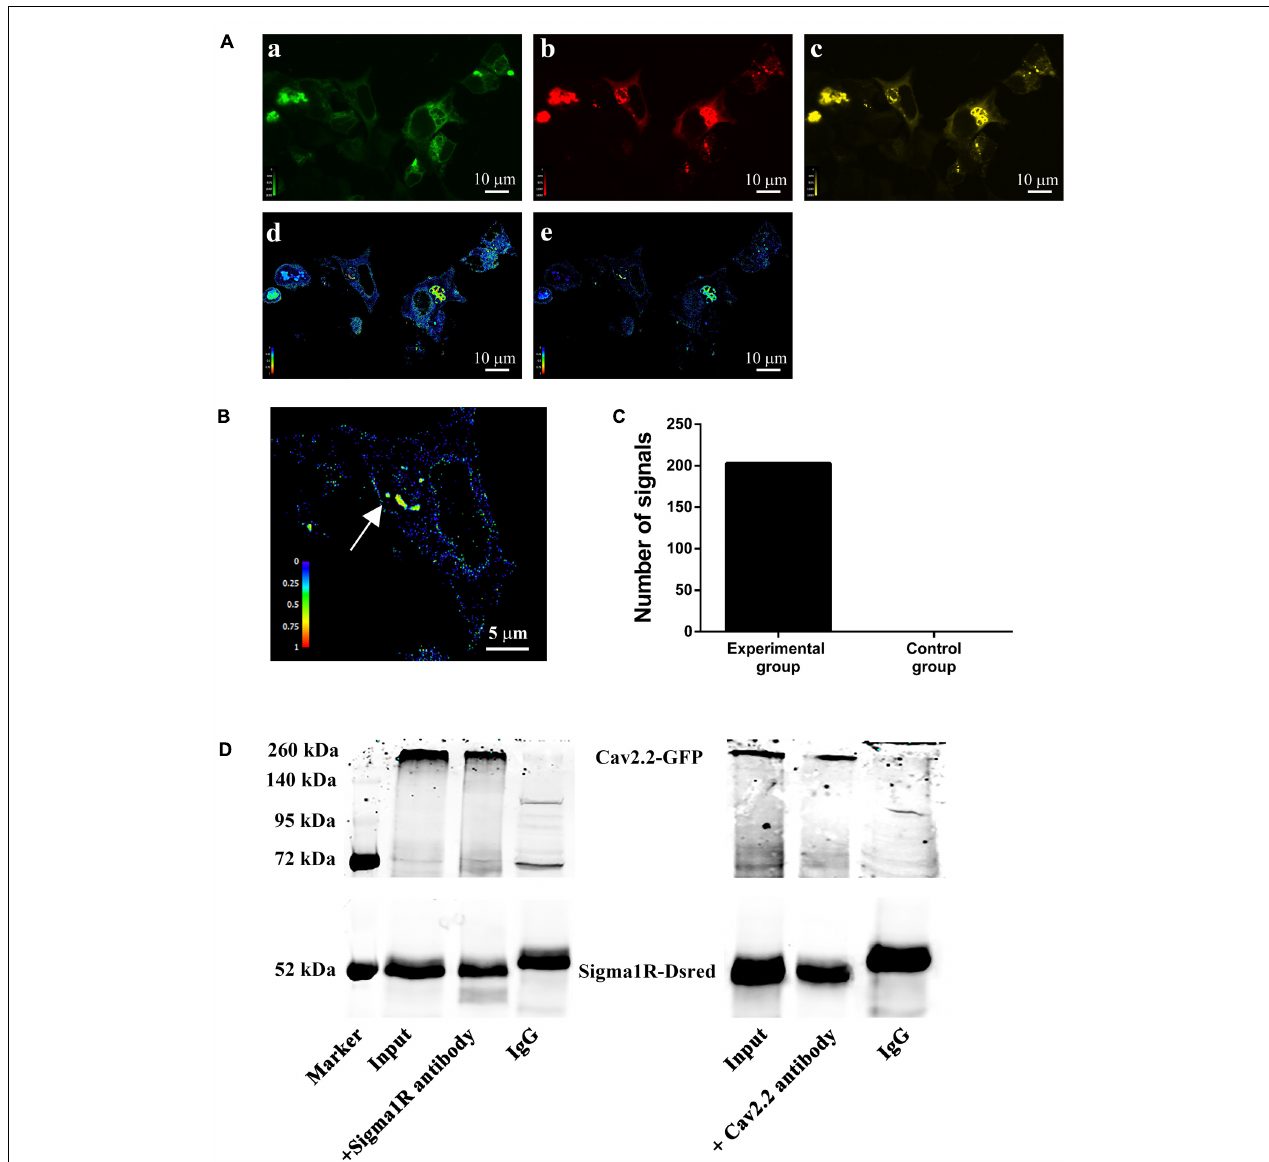
FIGURE 7 | Protein–protein interaction between sigma-1 receptors and N-type Ca 2 + channels. (A) HEK-293T cells were transfected with both Ca v 2.2-GFP ( α 1b+ β 1b+ α 2 δ 1) and sigma-1-Dsred receptor. Pseudo-color images were obtained under the three filter sets: GFP (a), Dsred (b), and FRET (c). After subtraction of background and bleed-through signals, net FRET (d) was acquired. Normalized FRET (e) values were got by using equation described in section “Materials and Methods.” Color bars represented relative degree of net FRET and normalized FRET within the cells. (B) Representative cell enlarged from (e). The net FRET value of the point with the arrow was 0.81 ± 0.06 (Mean ± SD). (C) Bar graph of the statistical numbers in 11 experimental fields (203) and 5 negative control fields (0). (D) Co-immunoprecipitation of GFP-Ca v 2.2 channels and sigma-1-Dsred receptors. Total lysates were prepared from HEK-293T cells. Immunoprecipitated